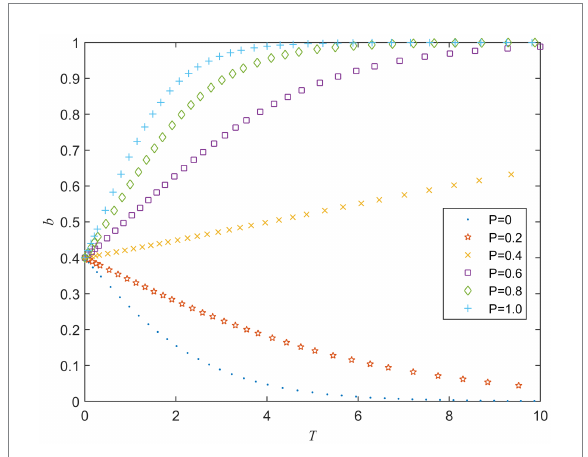
FIGURE 3 Strategy evolution of the private sector under different values of P .